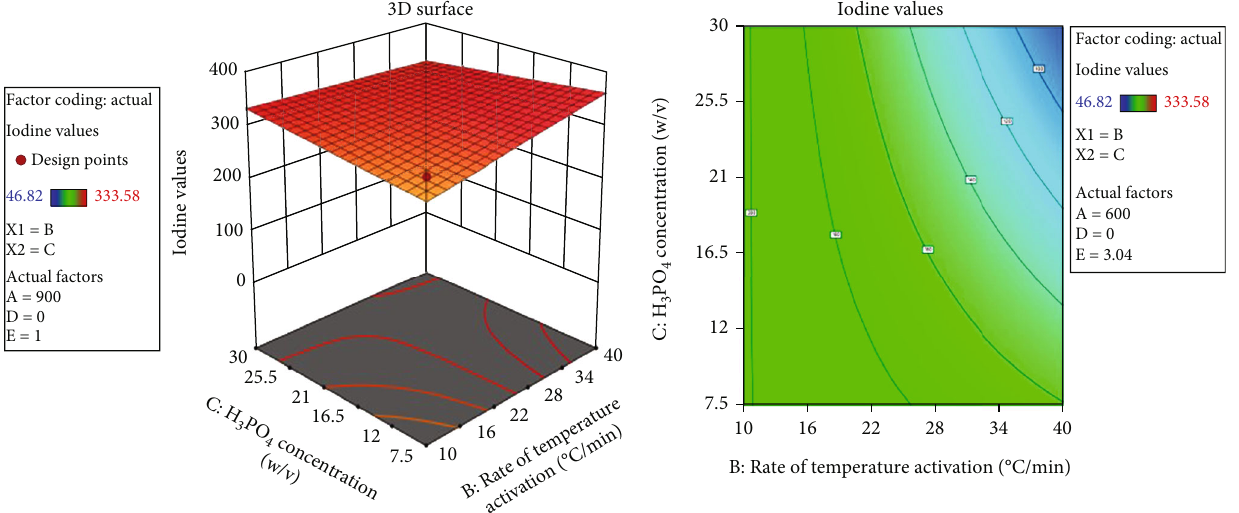
Figure 4: Surface and contour plots of rate of activation temperature based on input